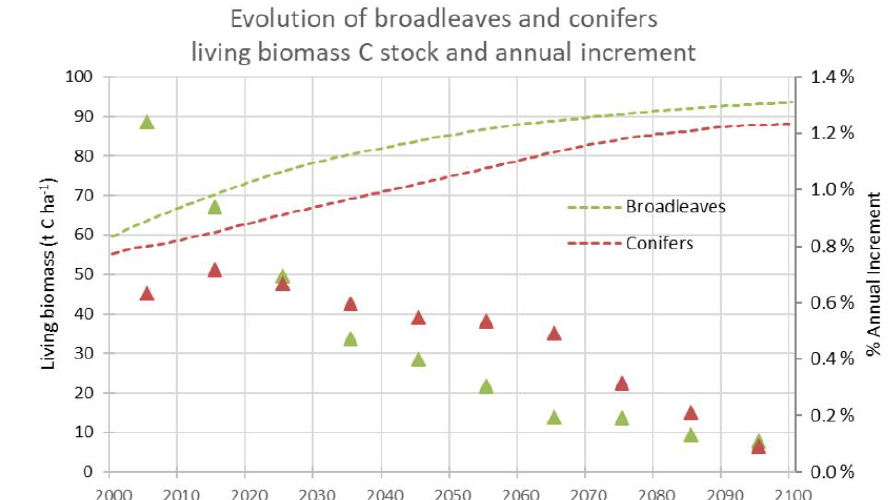
Figure 4. Temporal evolution of broadleaved species and conifers living biomass C stock (reported in tCha − 1 on the left axis – dashed lines), as estimated by CBM within the RS between 2000 and 2100. The right axis reports the evolution of the average percentage annual C-stock change estimated in 10-year time intervals